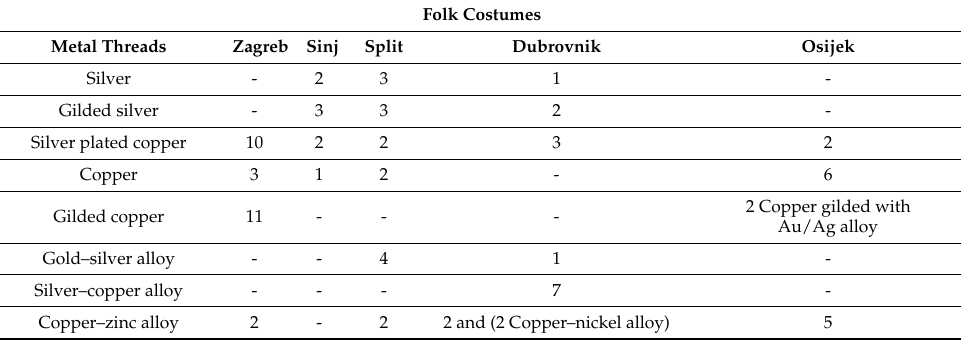
Table 4. Table of all metal thread samples from folk